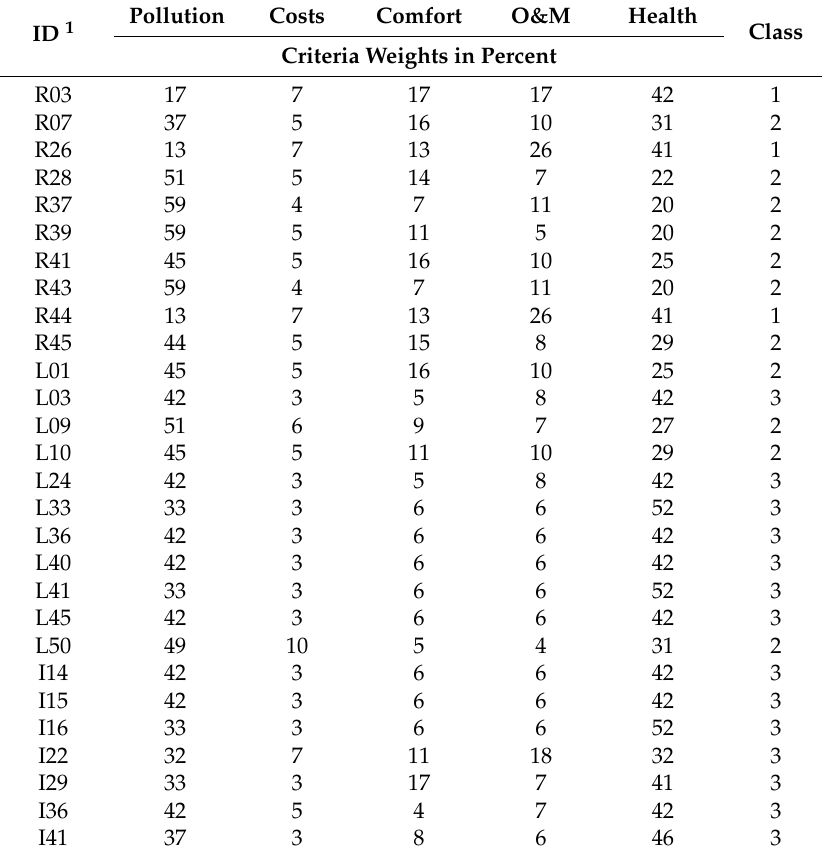
Table 1. Criteria weights of users with consistent